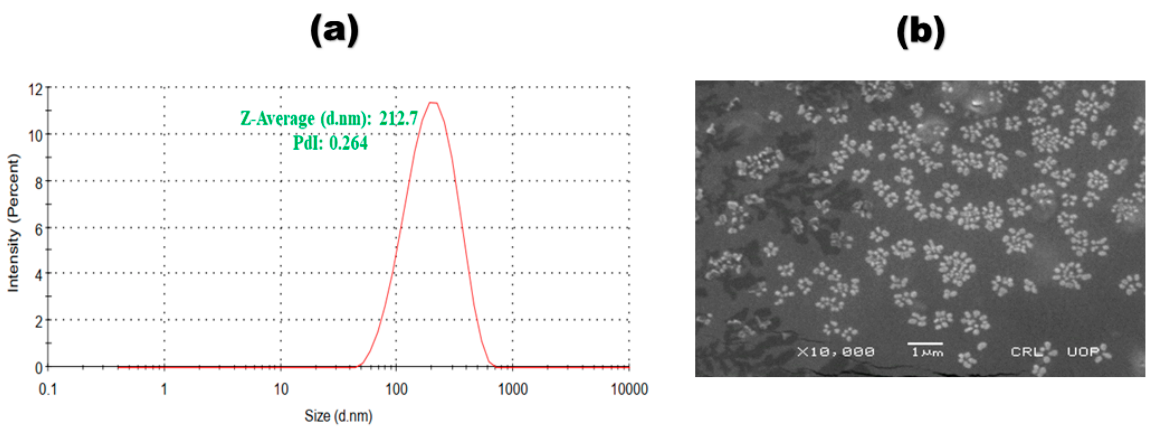
Figure 3. ( a ) Particle size and PDI and ( b ) SEM image of drug-loaded formulation.